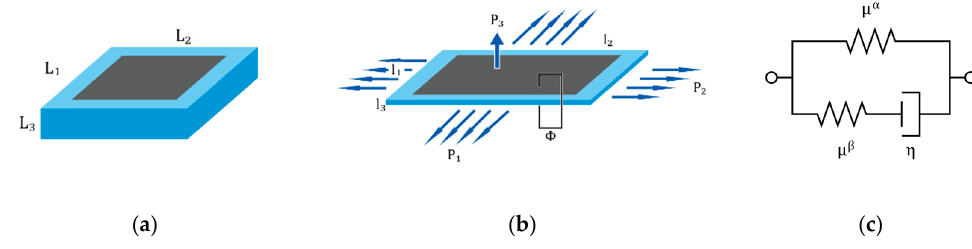
Figure 3. DE actuation schematic. ( a ) Reference state; ( b ) Current state; ( c ) Rheological model.